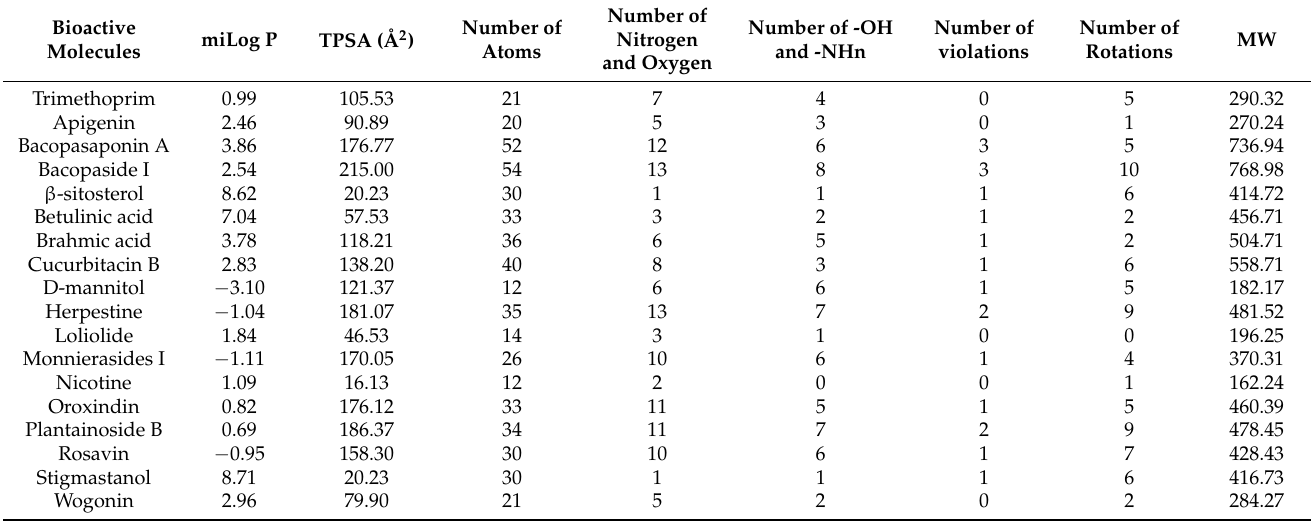
Table 5. Drug-likeness predictions of major bioactive molecules from B. monnieri .